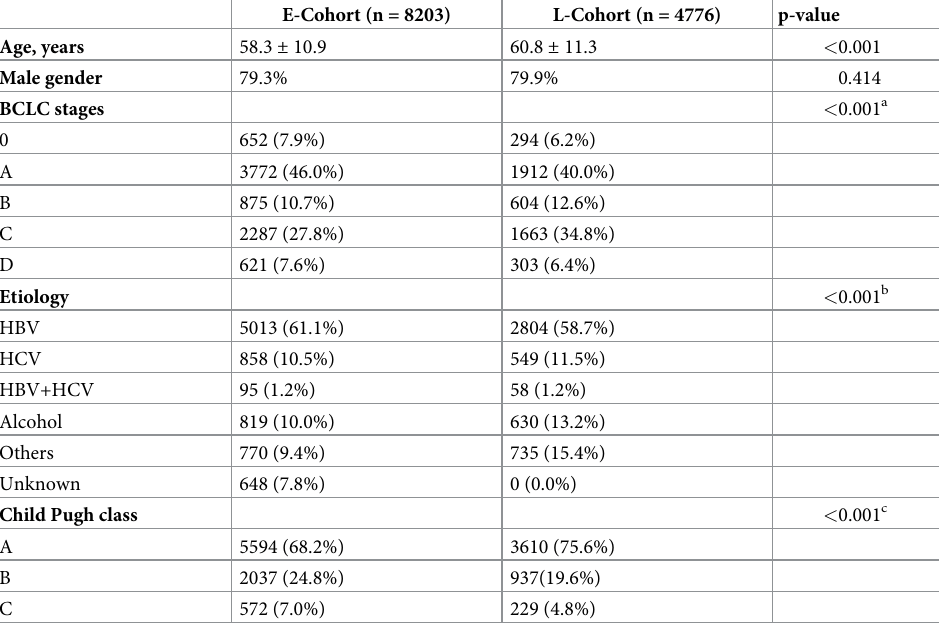
Table 1. Baseline clinical characteristics between the E-Cohort and the L-Cohort.